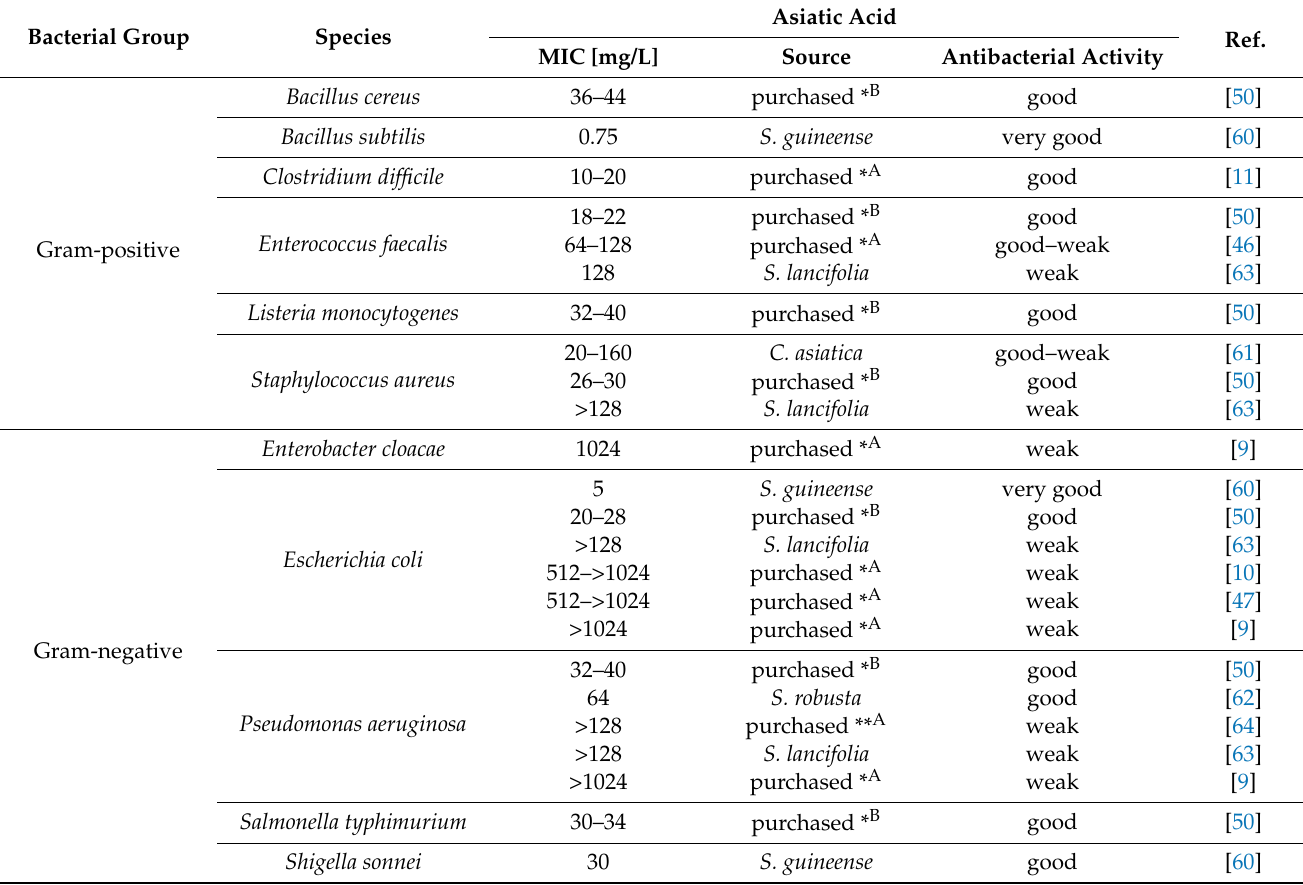
Table 1. MIC values of asiatic acid against Gram-positive and Gram-negative